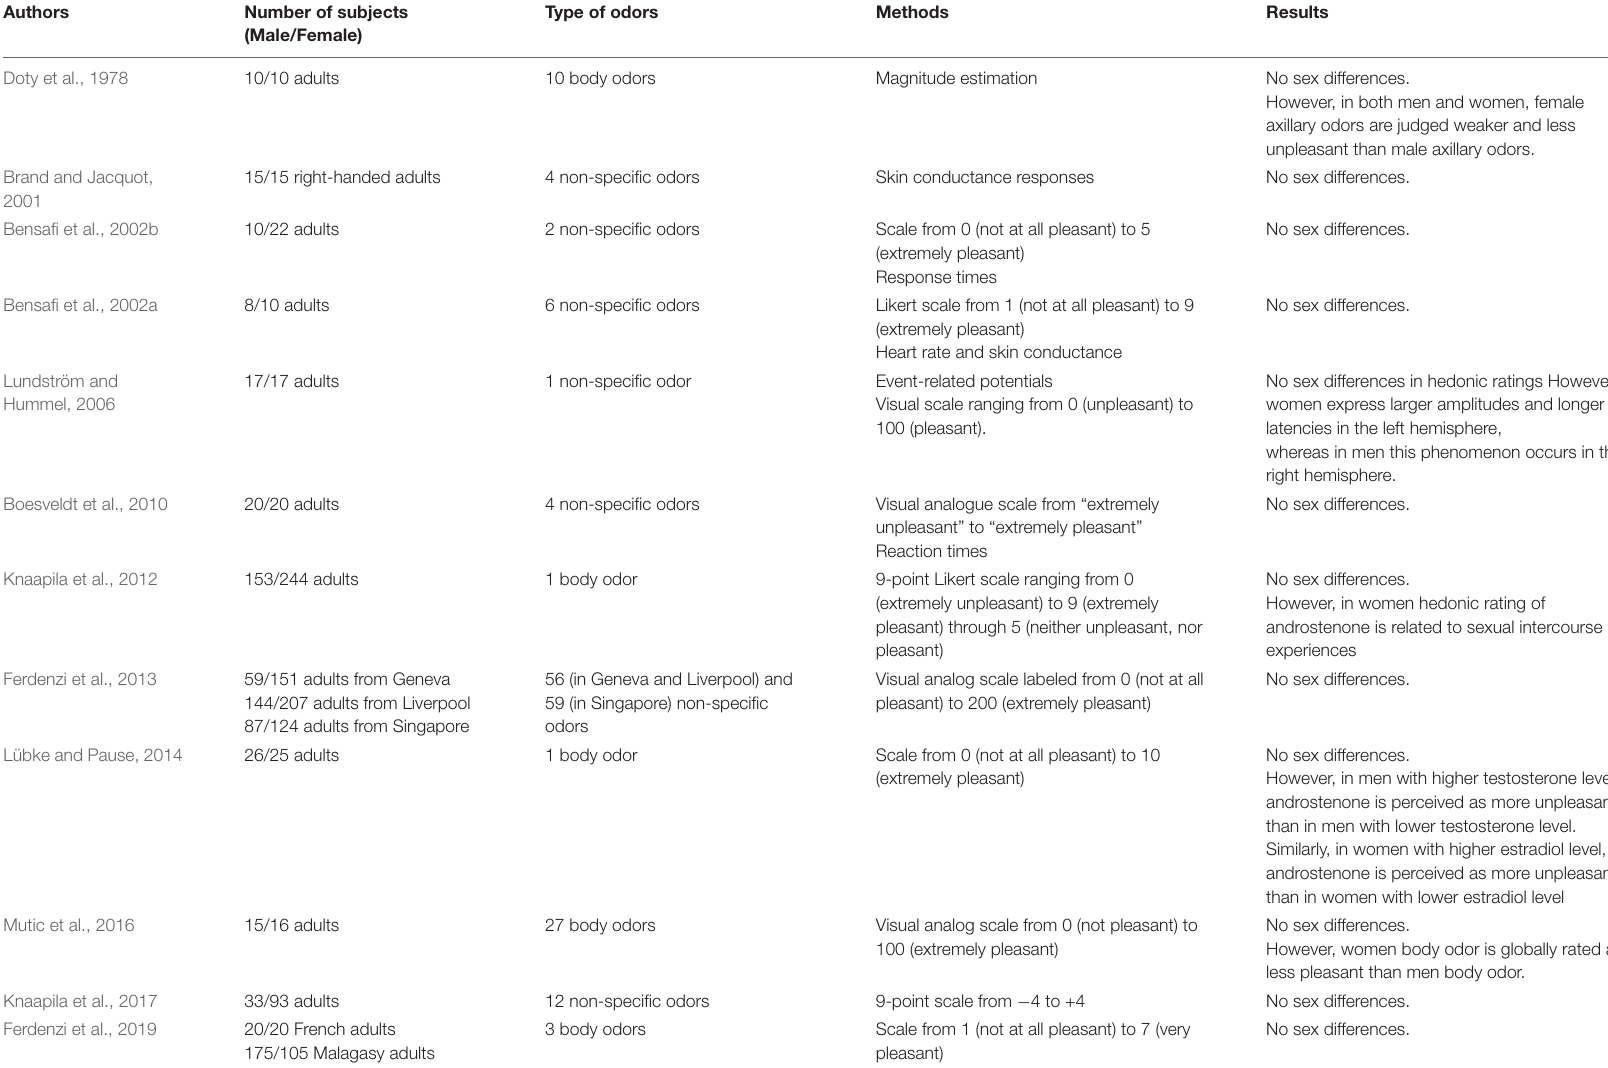
TABLE 2 | Summary of studies in healthy populations showing no sex differences in odor hedonic perception (non-specific odors and body